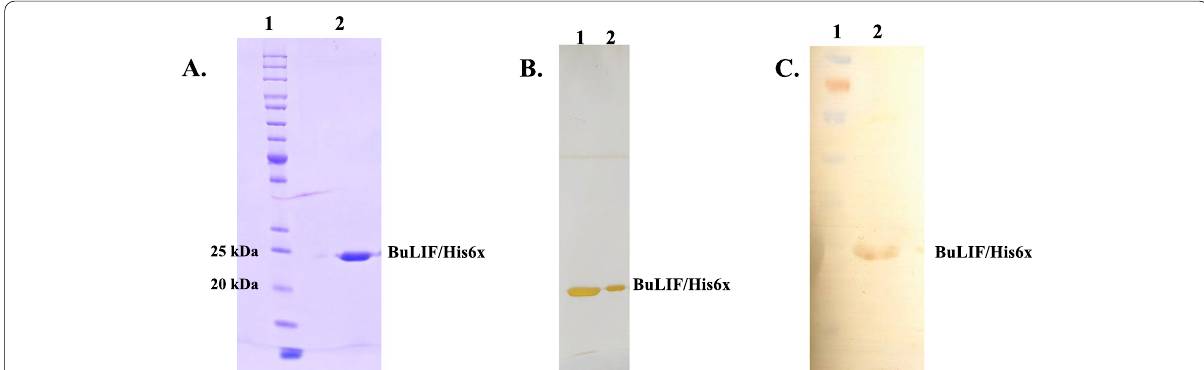
Fig. 3 Purification and western blot analysis of BuLIF. A Purified recombinant BuLIF/His6x obtained from Lemo 21 (DE3) was analyzed using SDS-PAGE. After IPTG induction, cells were incubated for 12 h and harvested by centrifugation. Supernatant was collected after cell lysis and loaded on to the Ni-NTA resin. Approximately 23 kDa recombinant BuLIF/His6x was purified by affinity chromatography. Lanes 1 and 2 indicate protein marker and purified protein respectively. B Silver staining was done to analyze the purity of recombinant protein. A single band was observed after staining. C Purified protein was confirmed by antiLIF antibody in dilution of 1:1000. The band was developed using DAB (3,3 ′ Diaminobenzidine) substrate on PDVF membrane after electro blotting. Lanes 1 and 2 indicate protein marker and confirmed recombinant protein